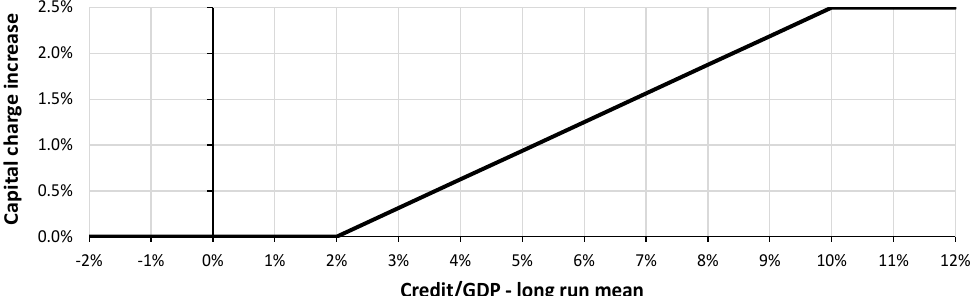
Credit/GDP -­‐ long run